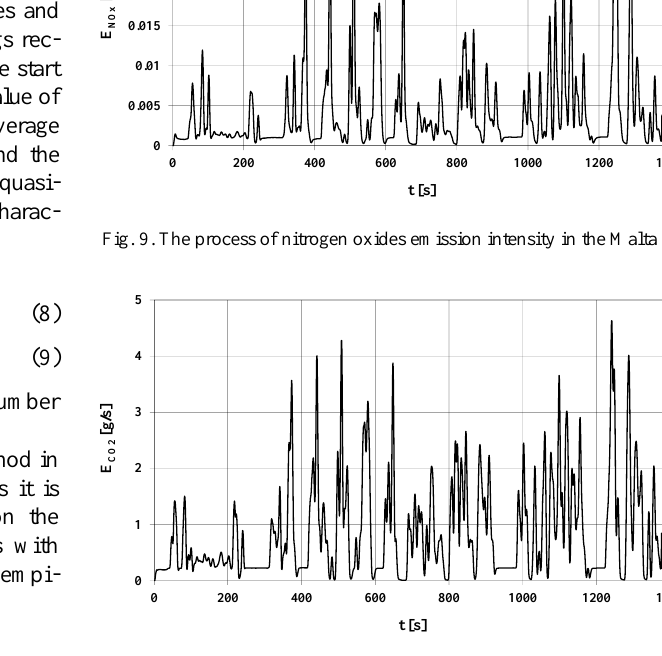
Fig. 10. The process of carbon dioxide emission intensity in the Malta test